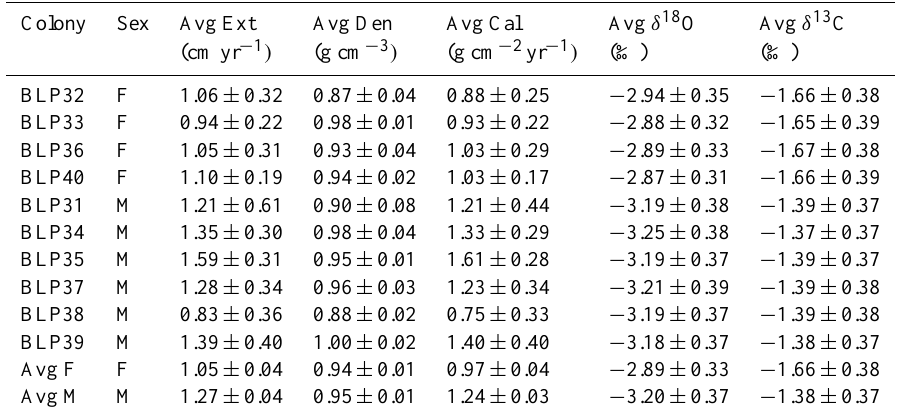
Table 1. Summary of the overall average extension rate, skeletal density, calcification rate, δ 18 O and δ 13 C of Porites panamensis colonies from Bahía de La Paz, Gulf of California. Time period of data is from 1997 to 2009.